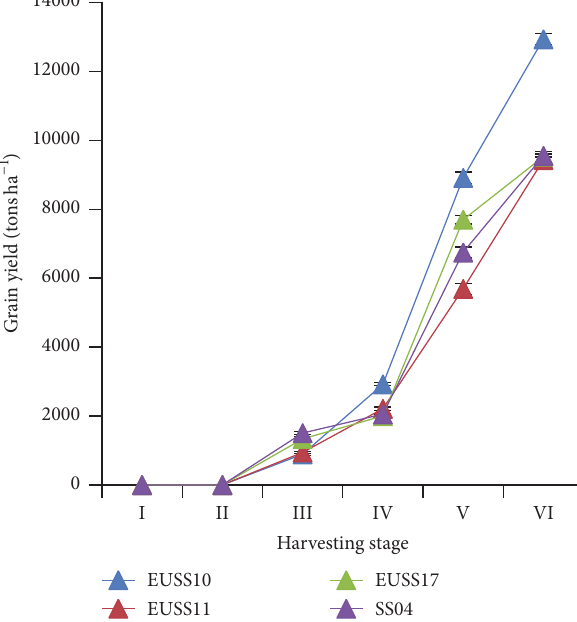
Figure 6: Effect of harvesting stage on juice yield of four sweet sorghum genotypes evaluated in part of western Kenya.